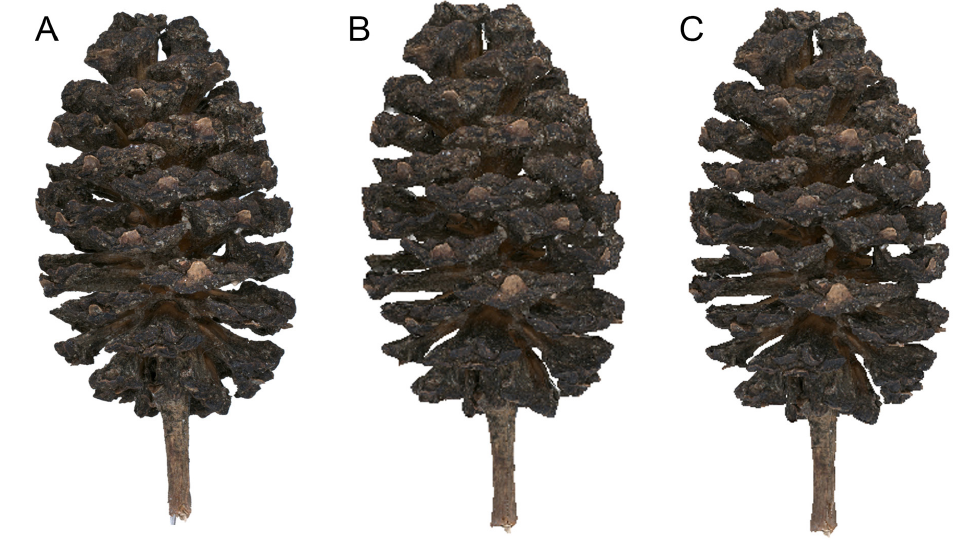
Fig. 3.13. Alnus japonica (2 cm long) scanned with DISC3D. A . EDOF-image. B . 3D-model (vcm) from 807 cameras. C . 3D-model from 398